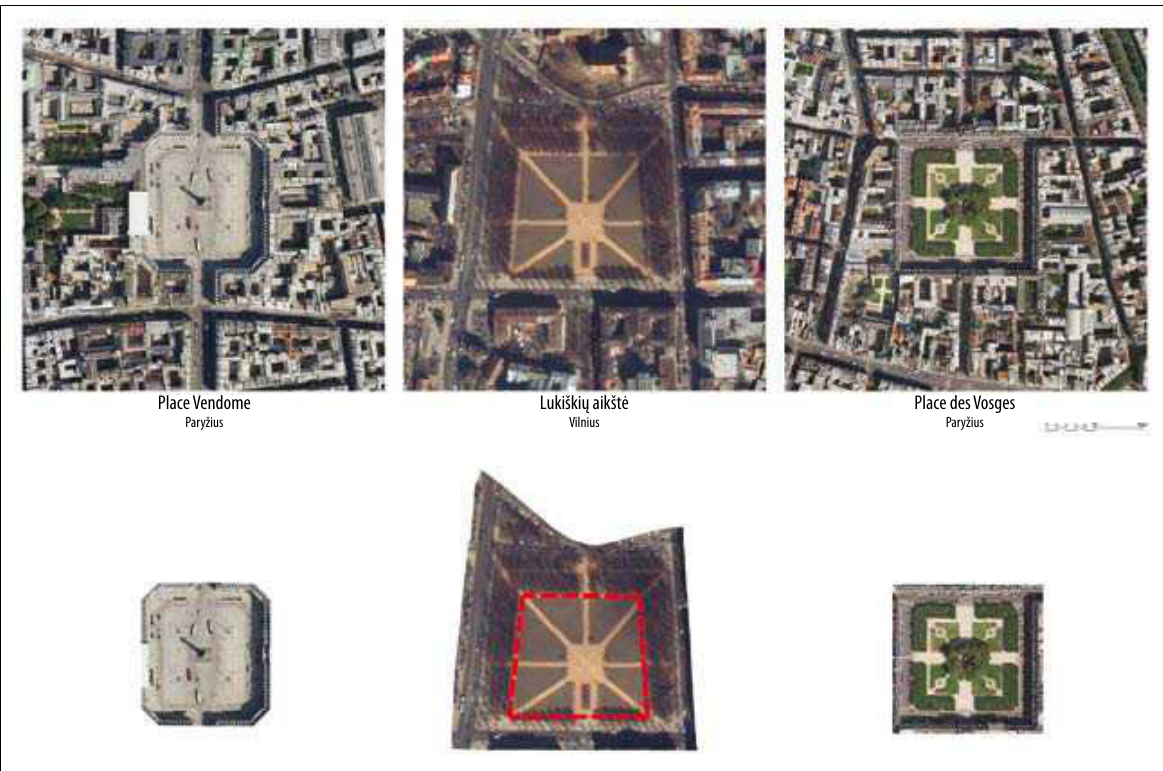
Fig. 9. Square size comparison of Lukiškės Square in Vilnius with de Vosges and Vandome Squares in